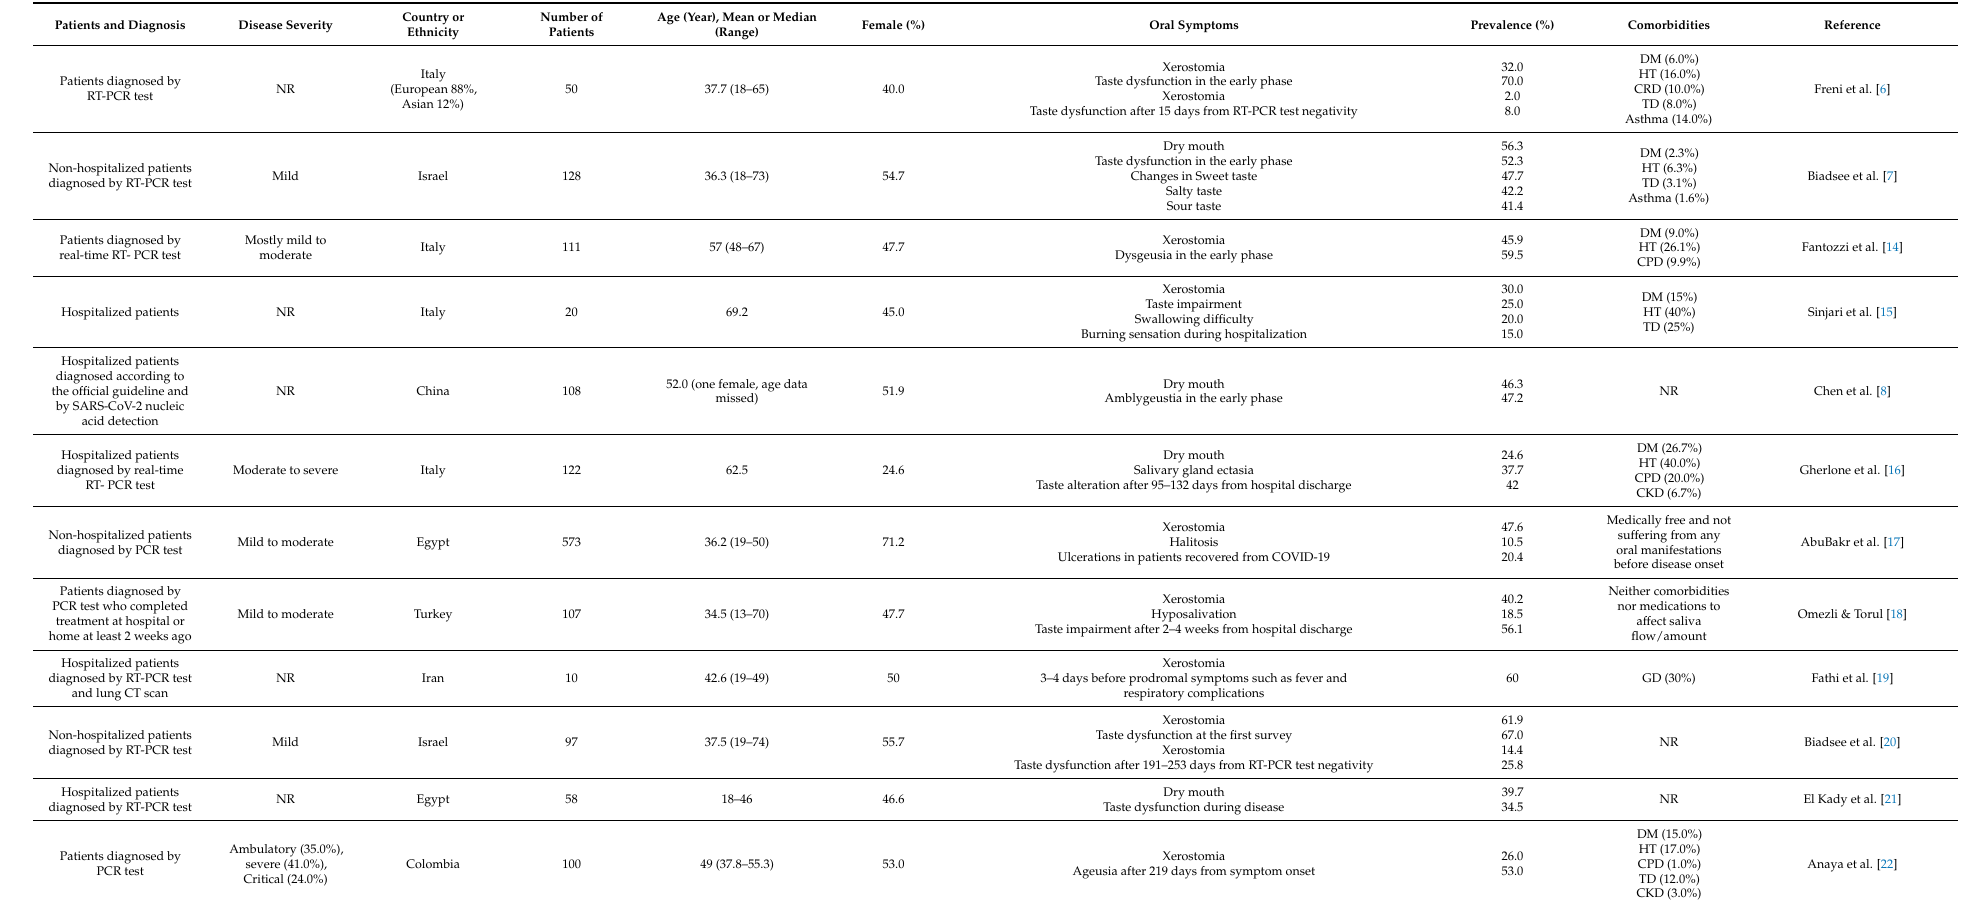
Table 1. Xerostomia, dry mouth and hyposalivation associated with